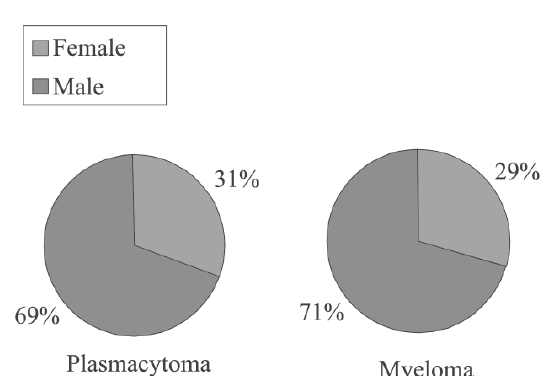
Figure 2 - Sex in patients with plasmacytoma and in patients with plasmacytoma that progressed to multiple myeloma (absolute and relative (%) frequency distribution)